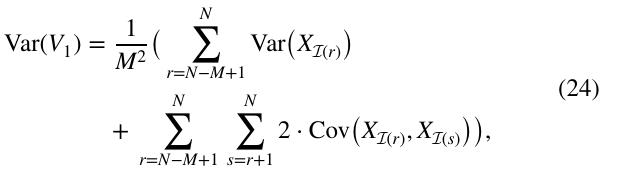
Y Z ( r ) / ( s ) represent the true value, the Y ( r ) . (R) With two noise levels, X n for some r and